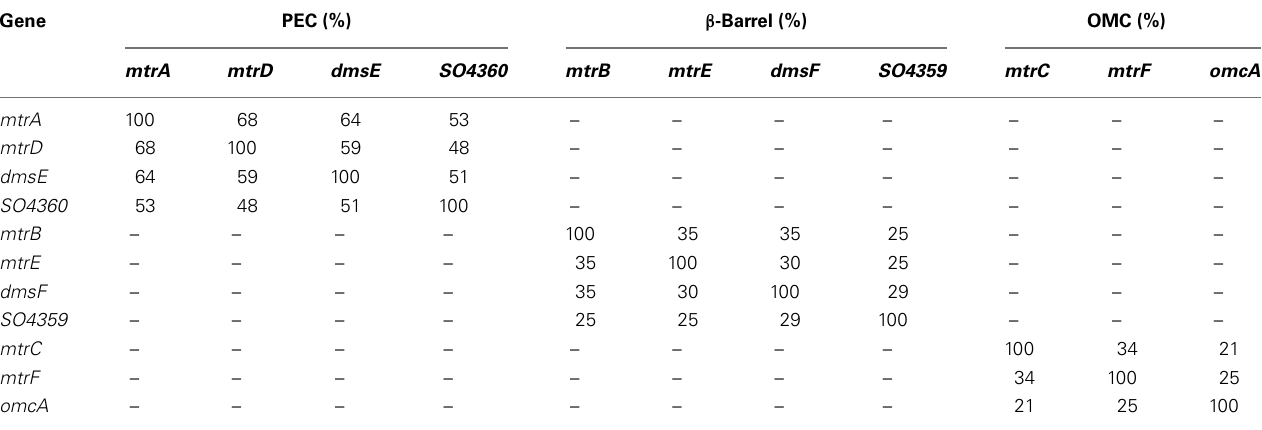
Table 1 |Amino acid identity between Mtr